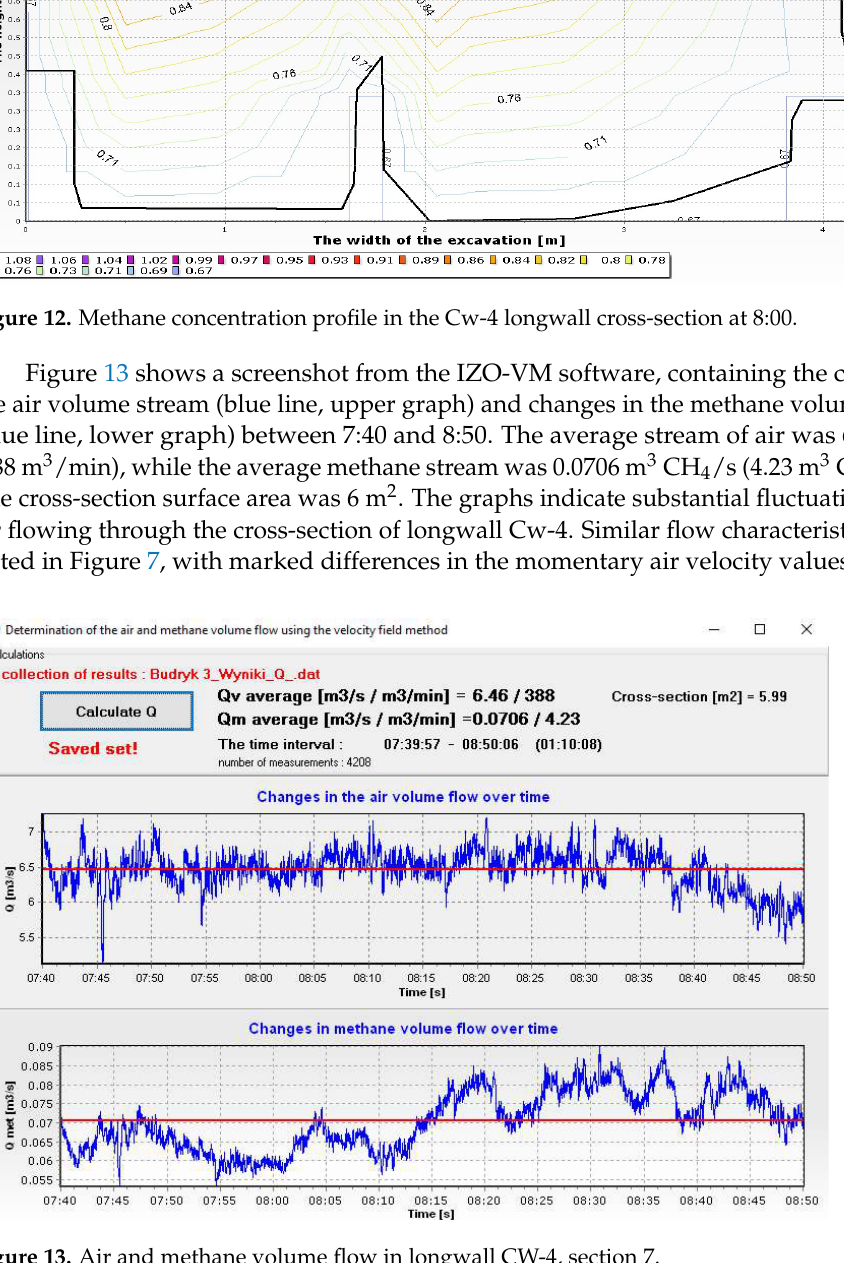
Figure 13. Air and methane volume flow in longwall CW-4, section 7.